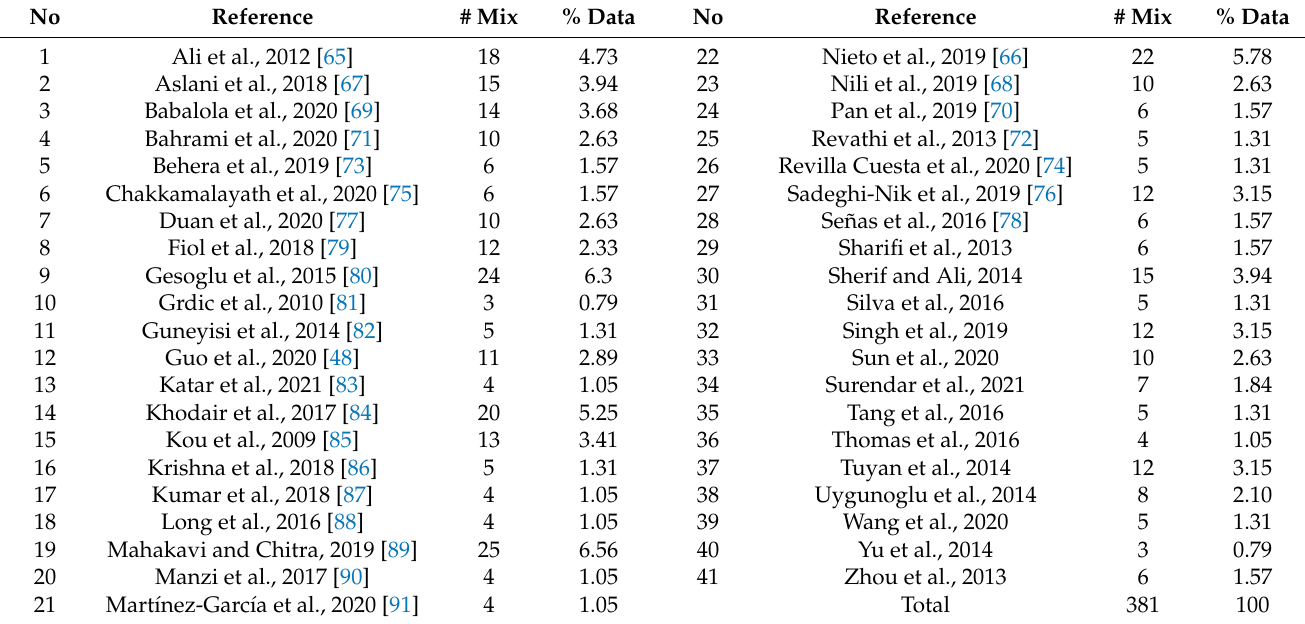
Table 1. Experimental database.